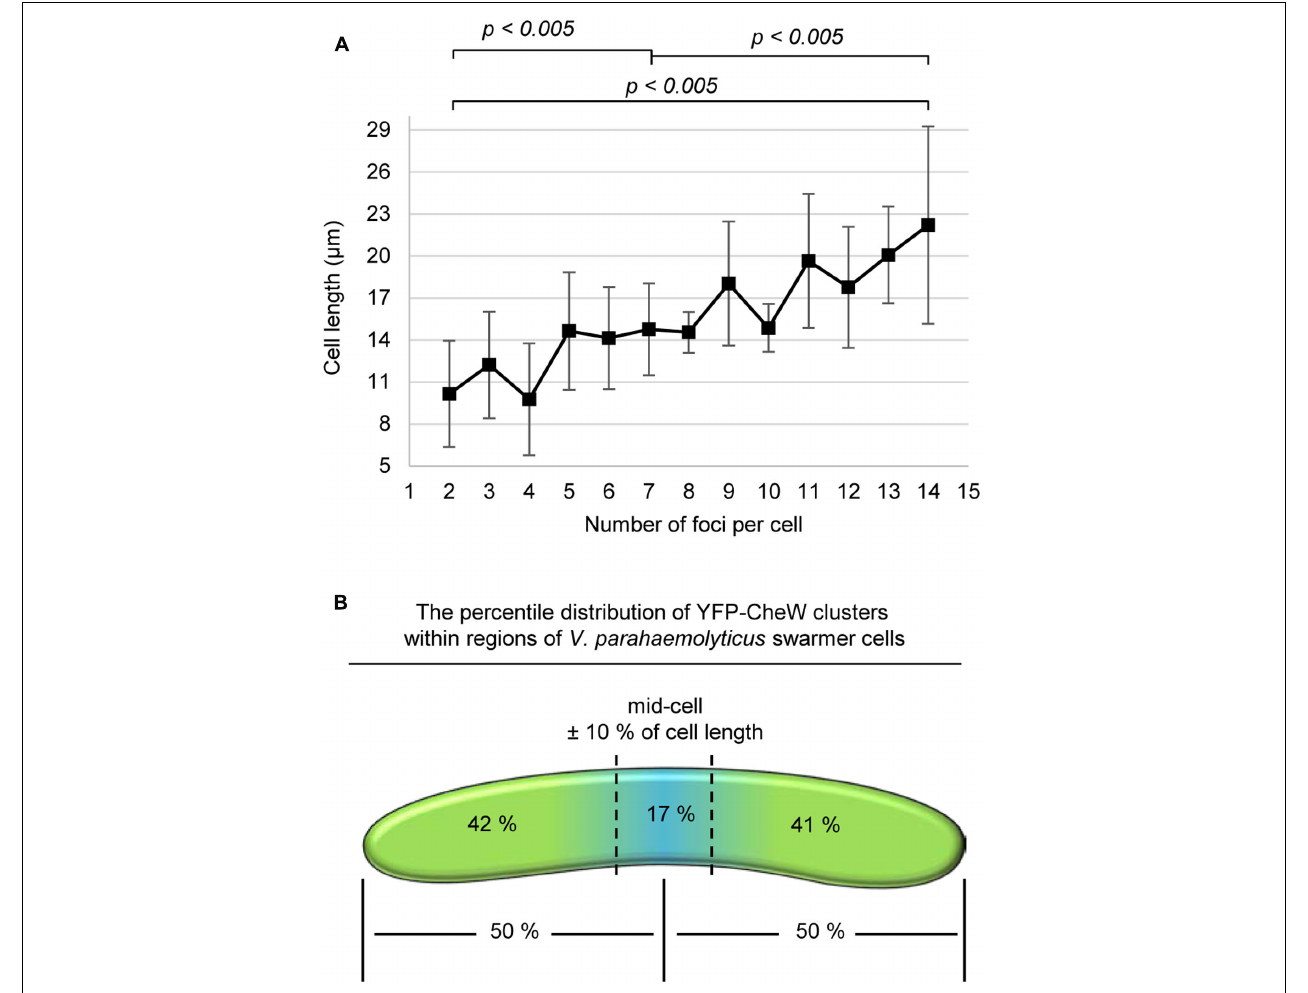
FIGURE 4 | A cell length dependent, non-regular distribution of lateral signaling arrays through-out the entire length of swarmer cells. (A) Graph depicting the number of YFP-CheW clusters as a function of cell length. (B) Schematic showing the percentile distribution of YFP-CheW clusters within regions of V. parahaemolyticus swarmer